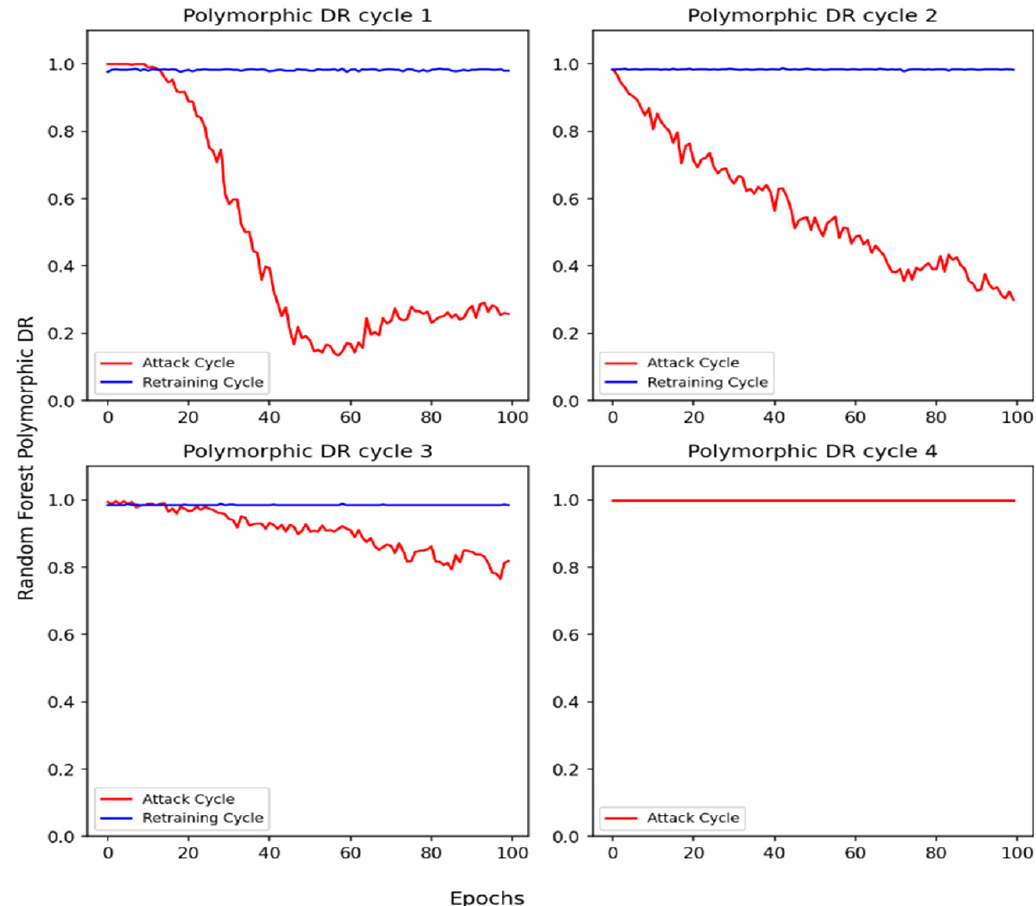
Figure 6. Polymorphic adversarial DDoS/DoS attack using Algorithm 3. Figure 7 depicts the DR results of the Random Forest IDS against polymorphic attacks synthesized by implementing Algorithm 4. We observe that the DR is dropped to almost zero after 100 epochs in cycle 1. After retraining, the DR improves to 70% which is lower as compared to cycle 1 in Figure 6. Gradually, after multiple attacks and retraining cycles (2–3), the IDS can capture the pattern of polymorphic attacks and can no longer be evaded. Figure 8 represents the evaluation of the attacker model based on the IDS Evasion Success Rate (ESR). It measures the success of the polymorphic adversarial attack in evading detection by the IDS. As shown in Figure 8, ESR in the adversarial cycle and attack cycles 1–2 is higher indicating that the attacker can successfully evade detection in these attack cycles. However, ESR reduces gradually after continuous updating and retraining of the IDS, indicating that it has learned the pattern and can now identify the attack with higher detection